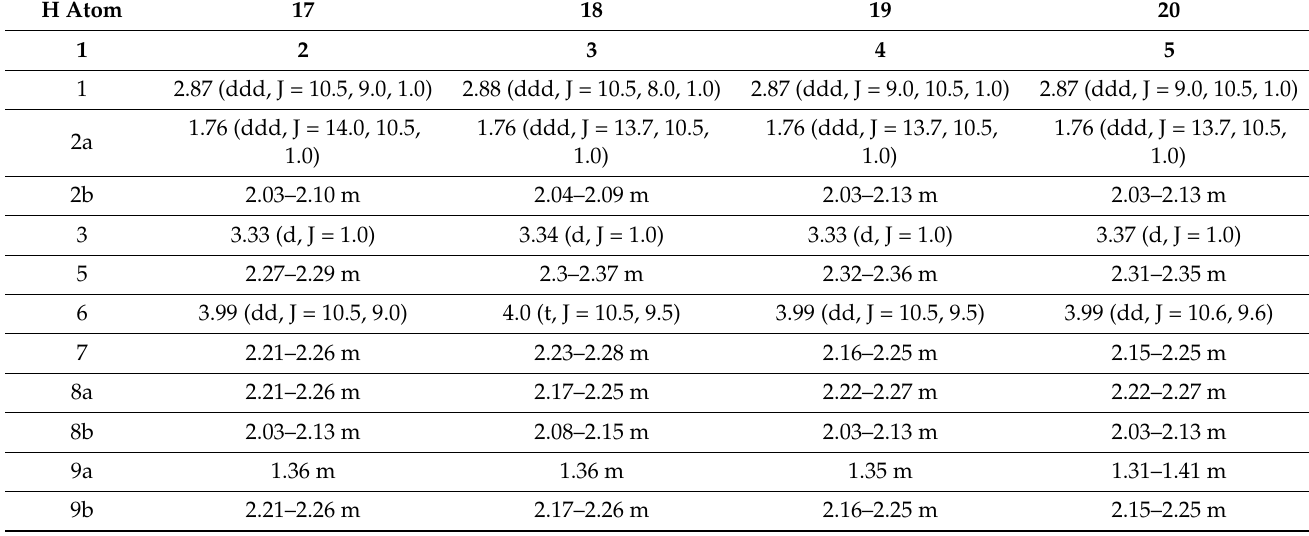
Table 3. 1 H NMR spectra data for derivatives 17 – 20 (500.16 MHz, CDCl 3 , δ , ppm,